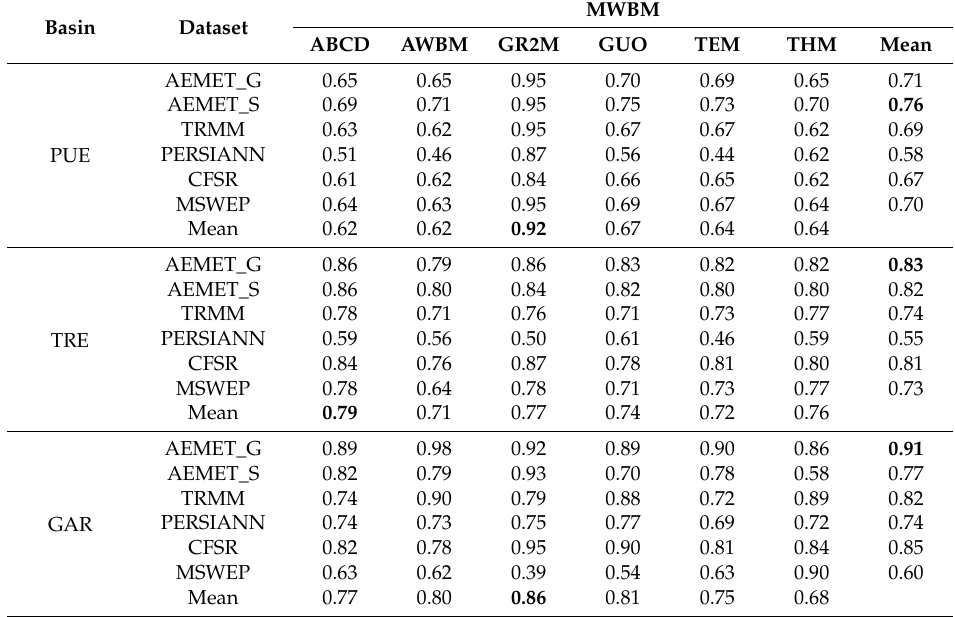
Table 5. Nash-Sutcliffe efficiency (NSE) of simulated streamflow for the different datasets using monthly water balance models (MWBMs) (best results in